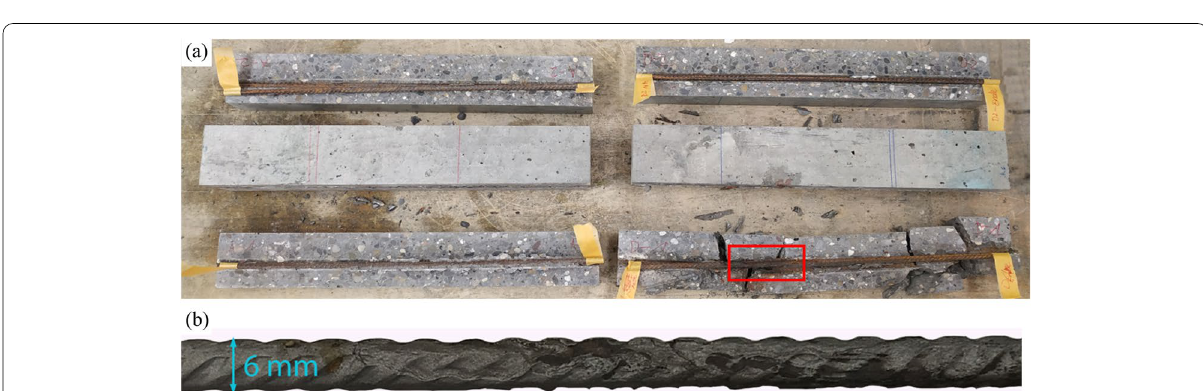
Fig. 14 A Splitting the reinforced mortar block with the anode marked with a red rectangle and ( B ) Detailed photo of the reinforcing steel with the anode after sandblasting with the cross-sectional steel loss on the steel with a diameter of 6